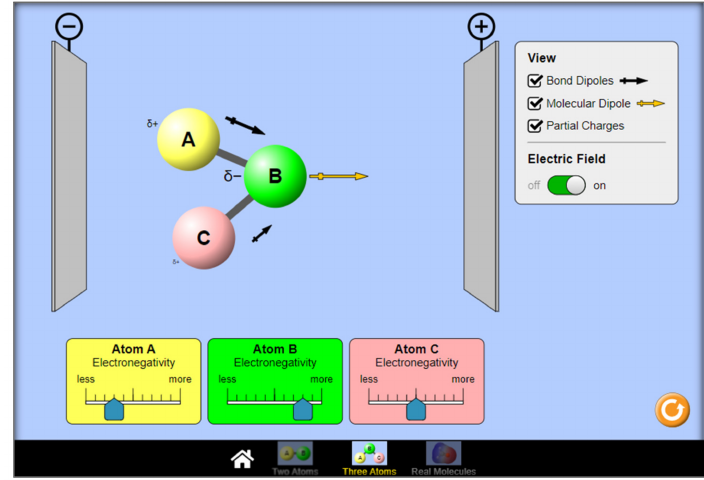
Figure 2. Simulation-based activity for learning molecule